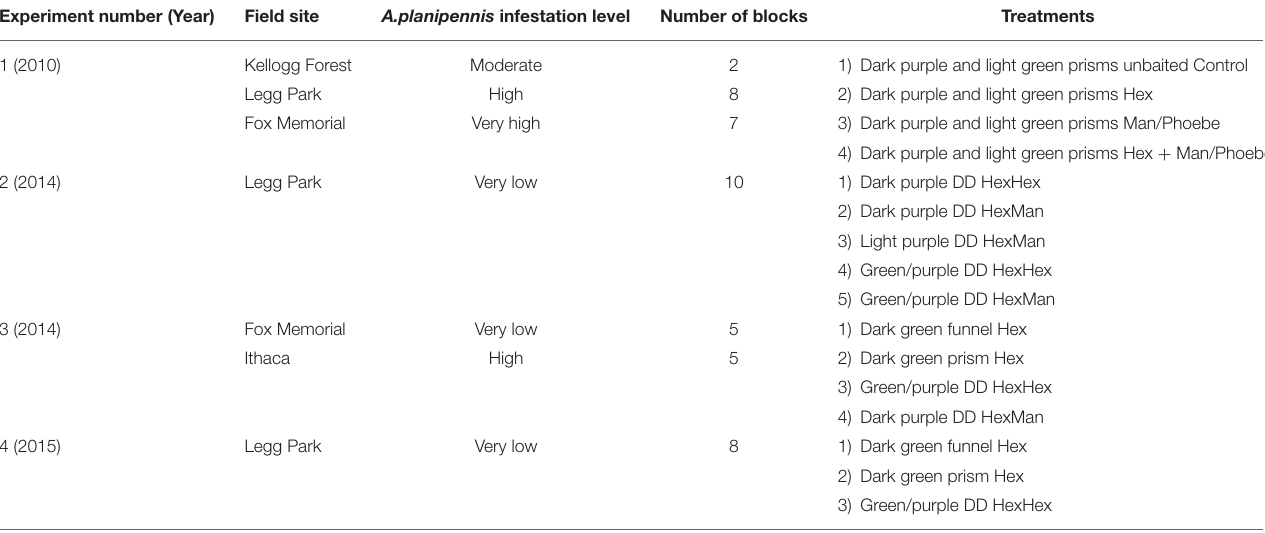
TABLE 1 | Field sites and treatments for A. planipennis trapping experiments in southern Michigan, 2010–2015. Experiment number